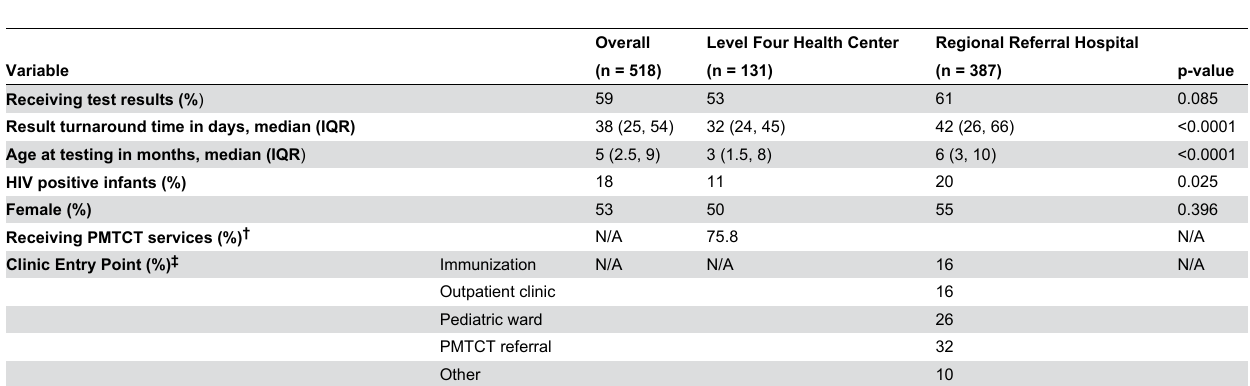
Table 1. Characteristics of the Study Sample from the Early Infant Diagnosis Program by